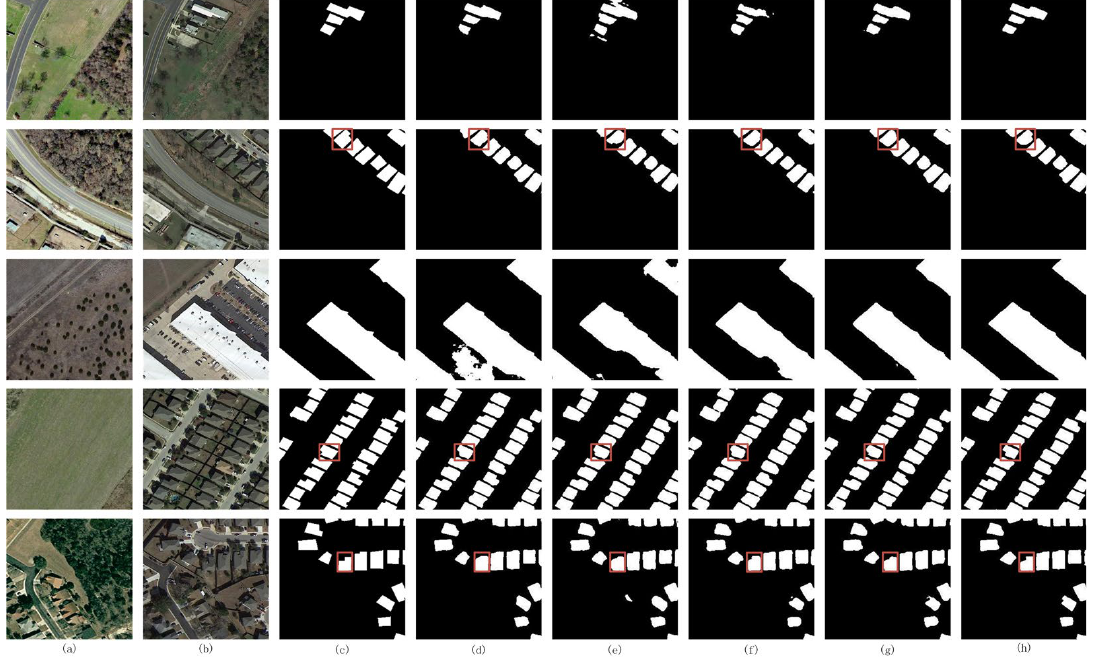
Figure 9. Comparative experimental results on the LEVIR-CD dataset. ( a ) Pretemporal images. ( b ) Posttemporal images. ( c ) Ground truth images. ( d ) Results of NestUnet. ( e ) Results of SNUNet. ( f ) Results of BIT. ( g ) Results of ChangeFormer. ( h ) Results of EGCTNet. (Ref boxes highlight areas in the image with significant differences.)